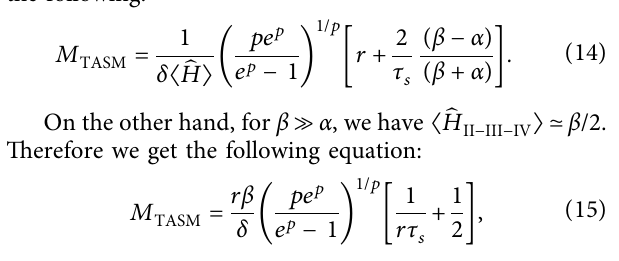
and F for interspecific models H 1 2 � 6 ( M � 4) in the case of F and to M 1 init init